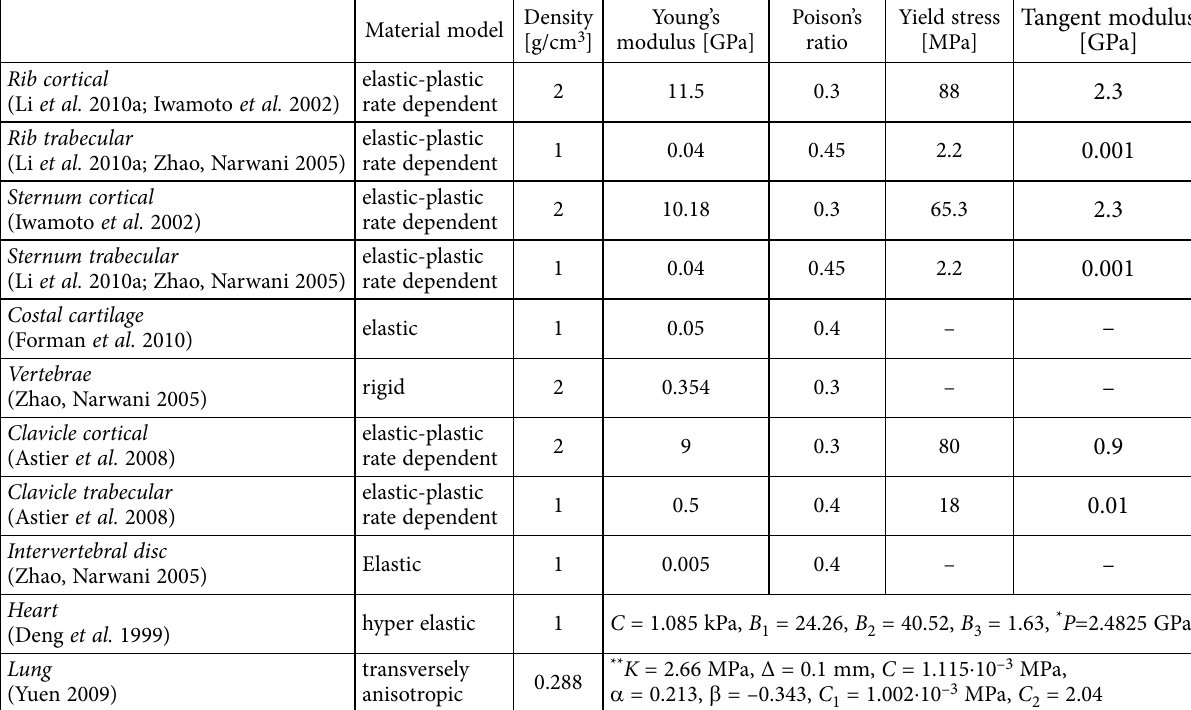
Table 1. Material parameters of the bones and main organs in the